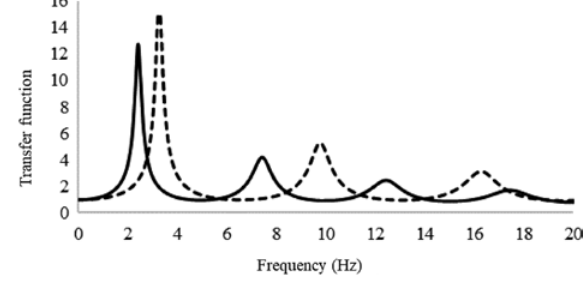
Figure 11: 1D soil-model.